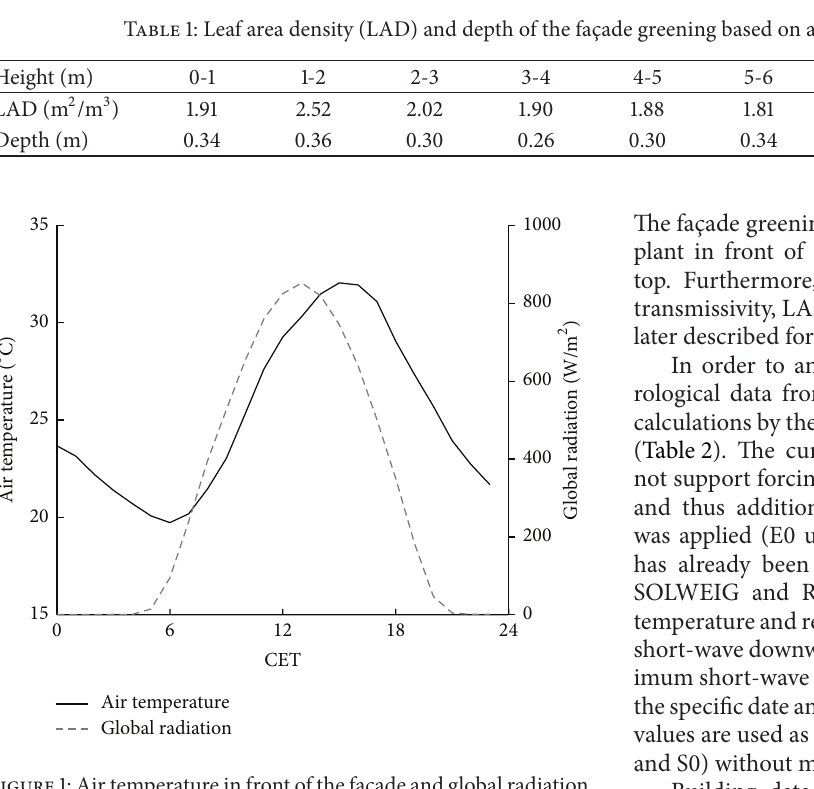
Figure 1: Air temperature in front of the fac¸ade and global radiation during the measurement campaign (7, 23,